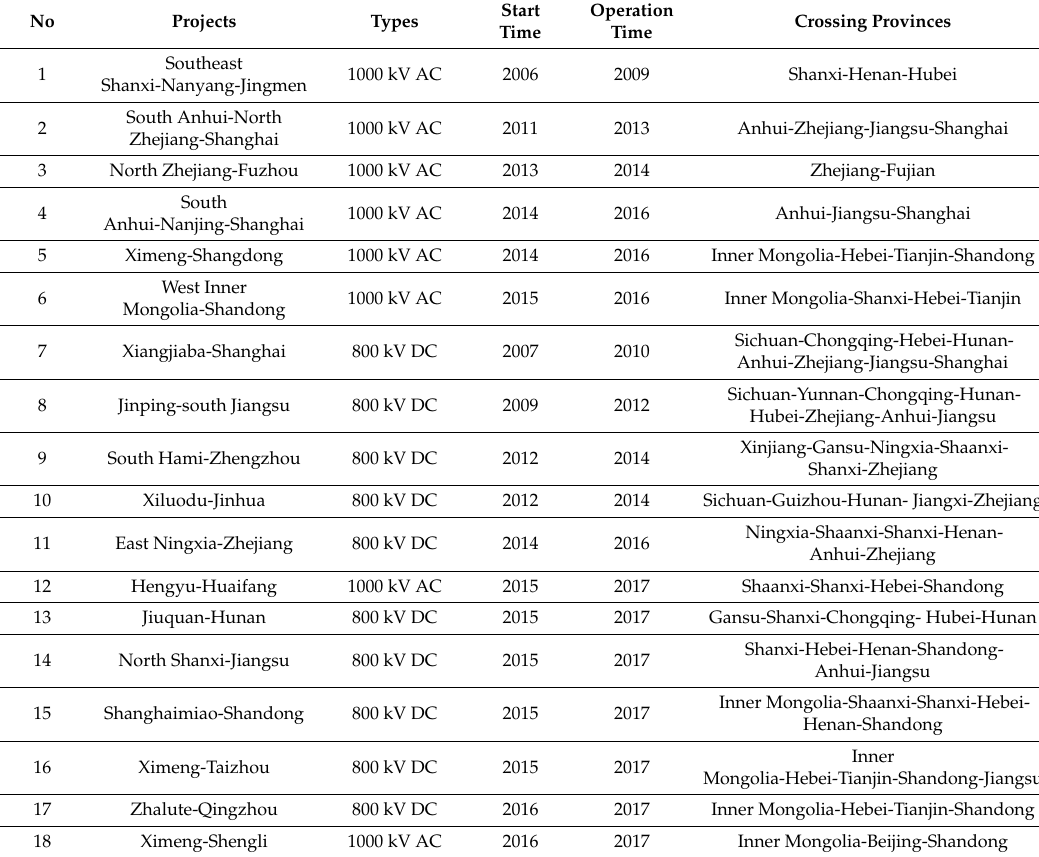
Table 5. “Eight ACs and Ten DCs” UHV power transmission projects of the State